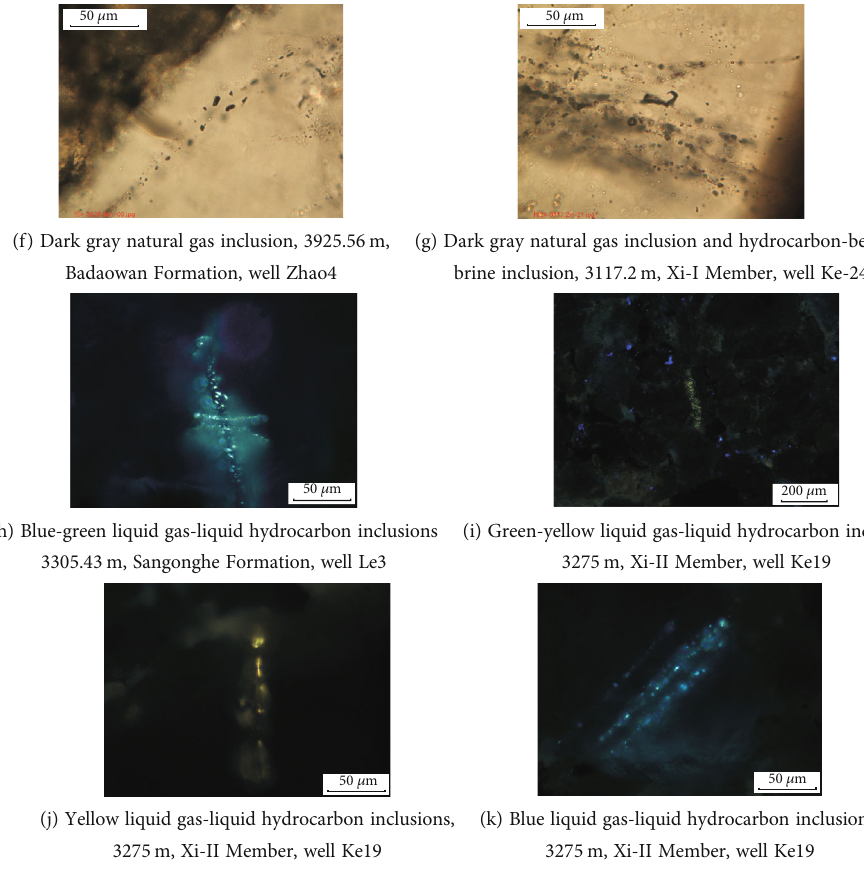
Figure 4: Characteristics and occurrences of hydrocarbon